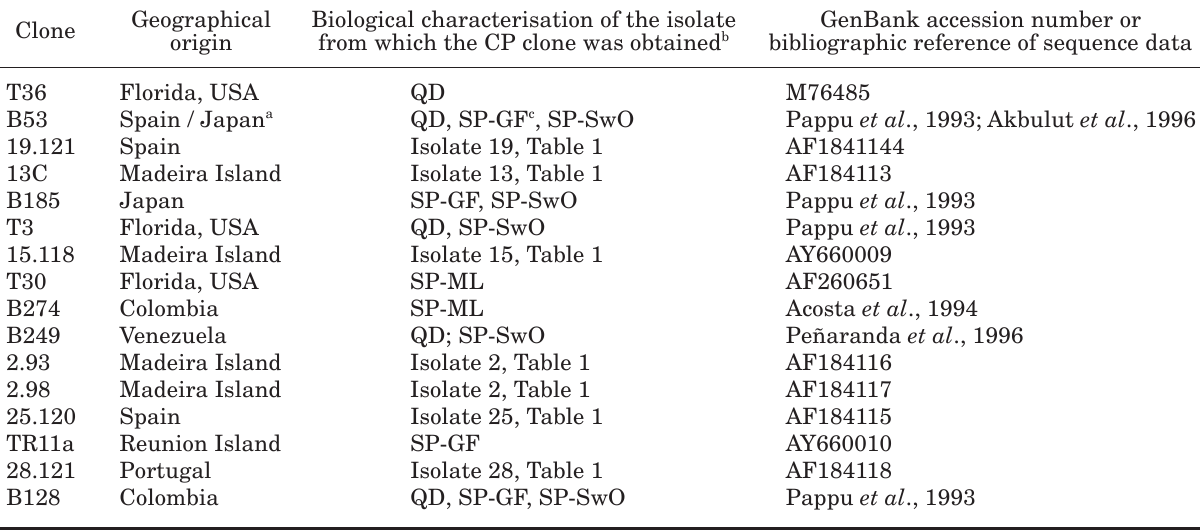
Table 2. Description of 16 cloned coat protein gene standards.